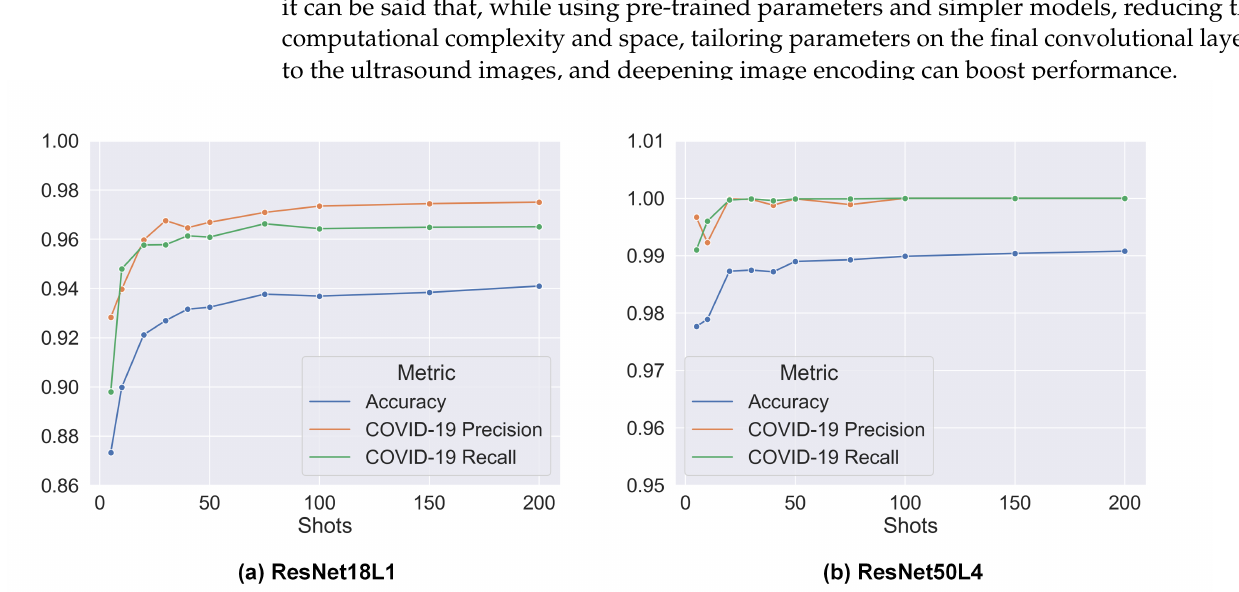
Figure 3. Performance results with increasing shots trained under 4-way condition: ( a ) Pre-trained ResNet18 with trainable parameters on the final connected layer and setting out features as the number of classes (ResNet18L1). ( b ) Pre-trained ResNet50 with trainable parameters on the last 3 convolutional layers and final connected layer